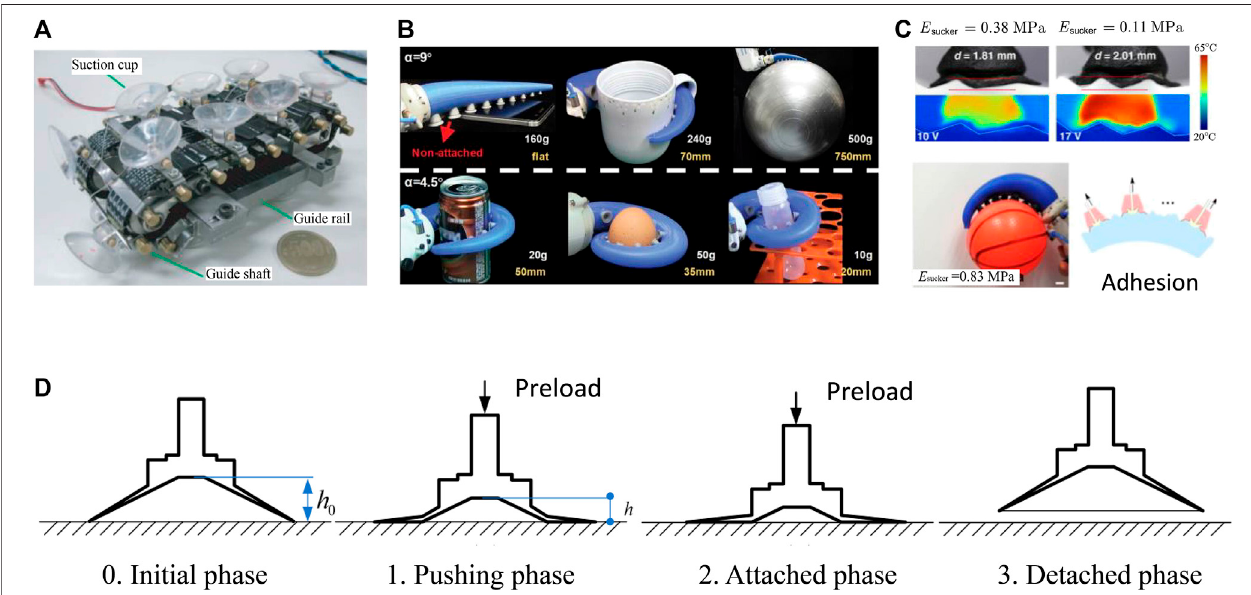
FIGURE 4 | Suction cup example applications and models. (A) Wall-climbing robots with suction cups as attaching components (reprinted with permission from ref (Yoshida and Ma, 2010)). (B) A suction-cup-based tapered soft actuator capabile of gripping objects of various shapes (reprinted with permission from ref (Xie et al., 2020)). (C) An organohydrogel-based soft gripper with electrically programmable stiffness for achieving conformable contact with rough surfaces. [reprintedwithpermissionfromref(Zhuoetal.,2020)]. (D) Schematicsofapressing-detachingprocessofasuctioncup[reprintedwithpermissionfromref(Ge et al.,